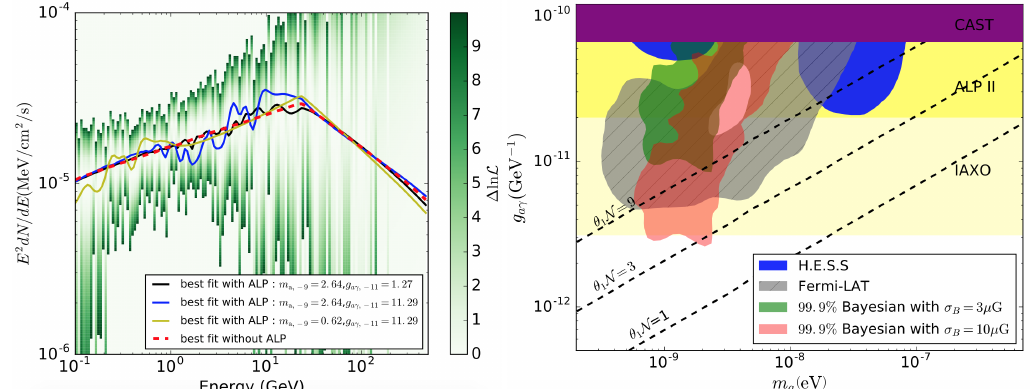
Figure 7. ( Left ) Likelihood curves for the observed spectrum of PKS 2155-304. Solid lines represent, best fits including the photon–ALP oscillations and best spectral fit without oscillations included. Reprinted from Zhang et al. [76]. ( Right ) Comparison of exclusion regions derived in [76], compared with exclusion regions from H.E.S.S. observations of PKS-2155- 304 [39] and Fermi -LAT observations of NGC 1275 [44]. Reprinted from Zhang et al.